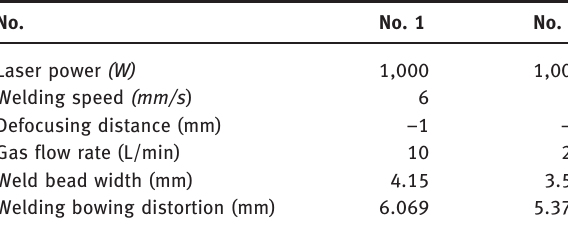
Table 12: Welding parameters and bead width corresponding to Figure 14.